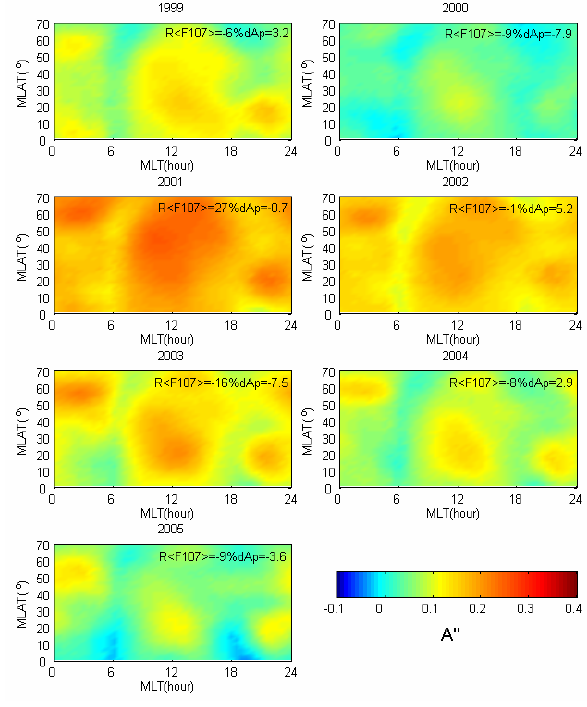
Fig. 3b. Figure 3b